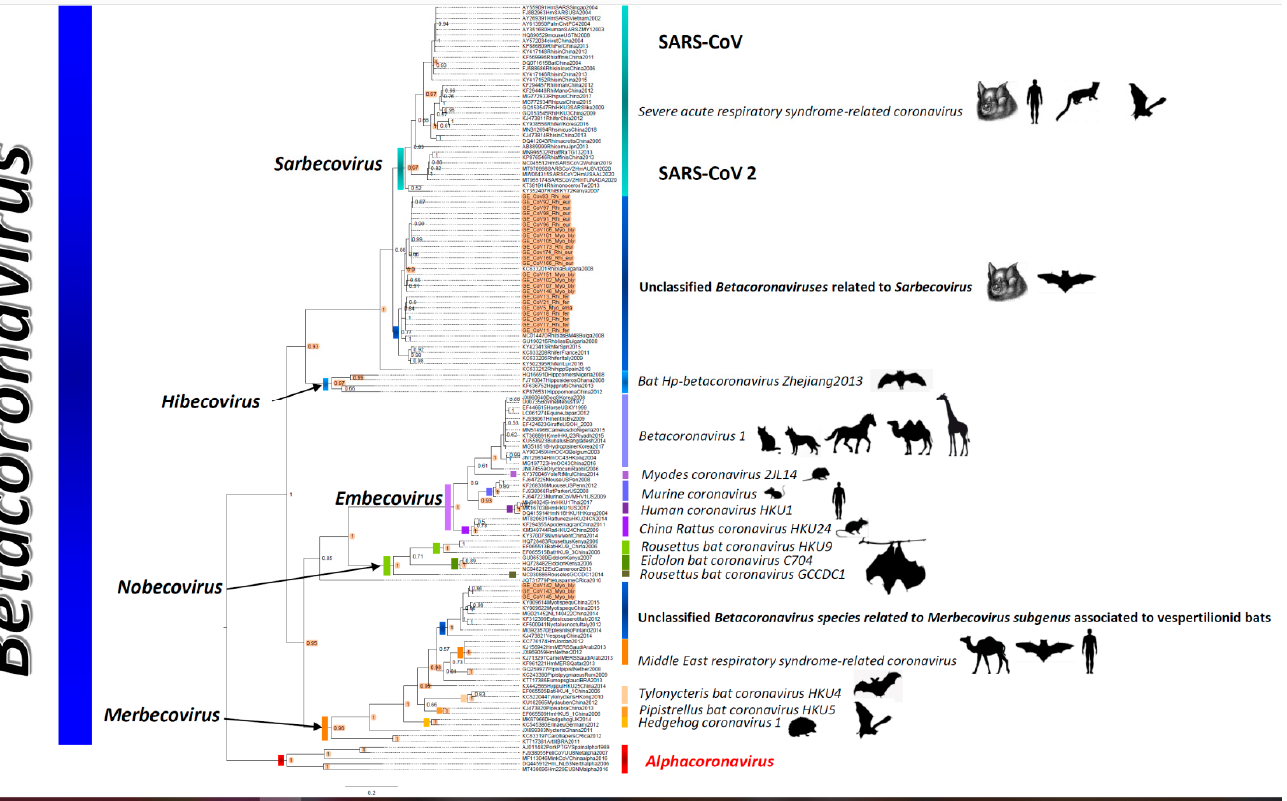
Figure 3. Unrooted Bayesian phylogenetic tree for beta CoVs generated with a partial informative 411 bp fragment of the RdRp. Representative BetaCoV taxa were used in the alignment to demonstrate consistent segregation between both genera. Values at nodes represent branch support values expressed as Bayesian posterior probabilities. Scale bar indicates branch lengths. Highlighted nodes are robustly supported with colored bars indicating relevant branches encompassing taxa pertaining to a given subgenus on the left. Bars on the right indicate taxa pertaining to recognized CoV species according to the most recent ICTV classification scheme. Taxa highlighted in orange on the right side of the tree indicate CoV sequences obtained from Georgian bats, and the dark blue bars indicate unclassified CoV species. Taxa names for all reference sequences in the tree start with their respective GenBank accession number. Animal silhouettes on the extreme right indicate the animal species from which reference sequences were